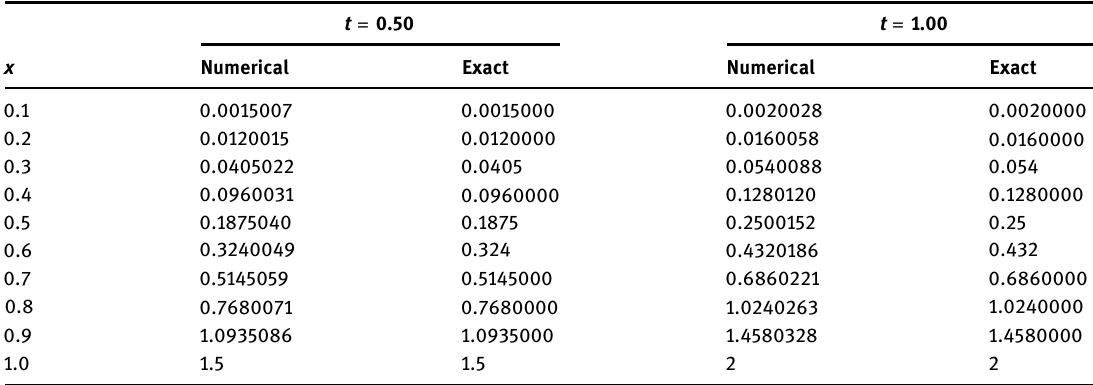
Table 2: U i j , and u i j , with α 0.5